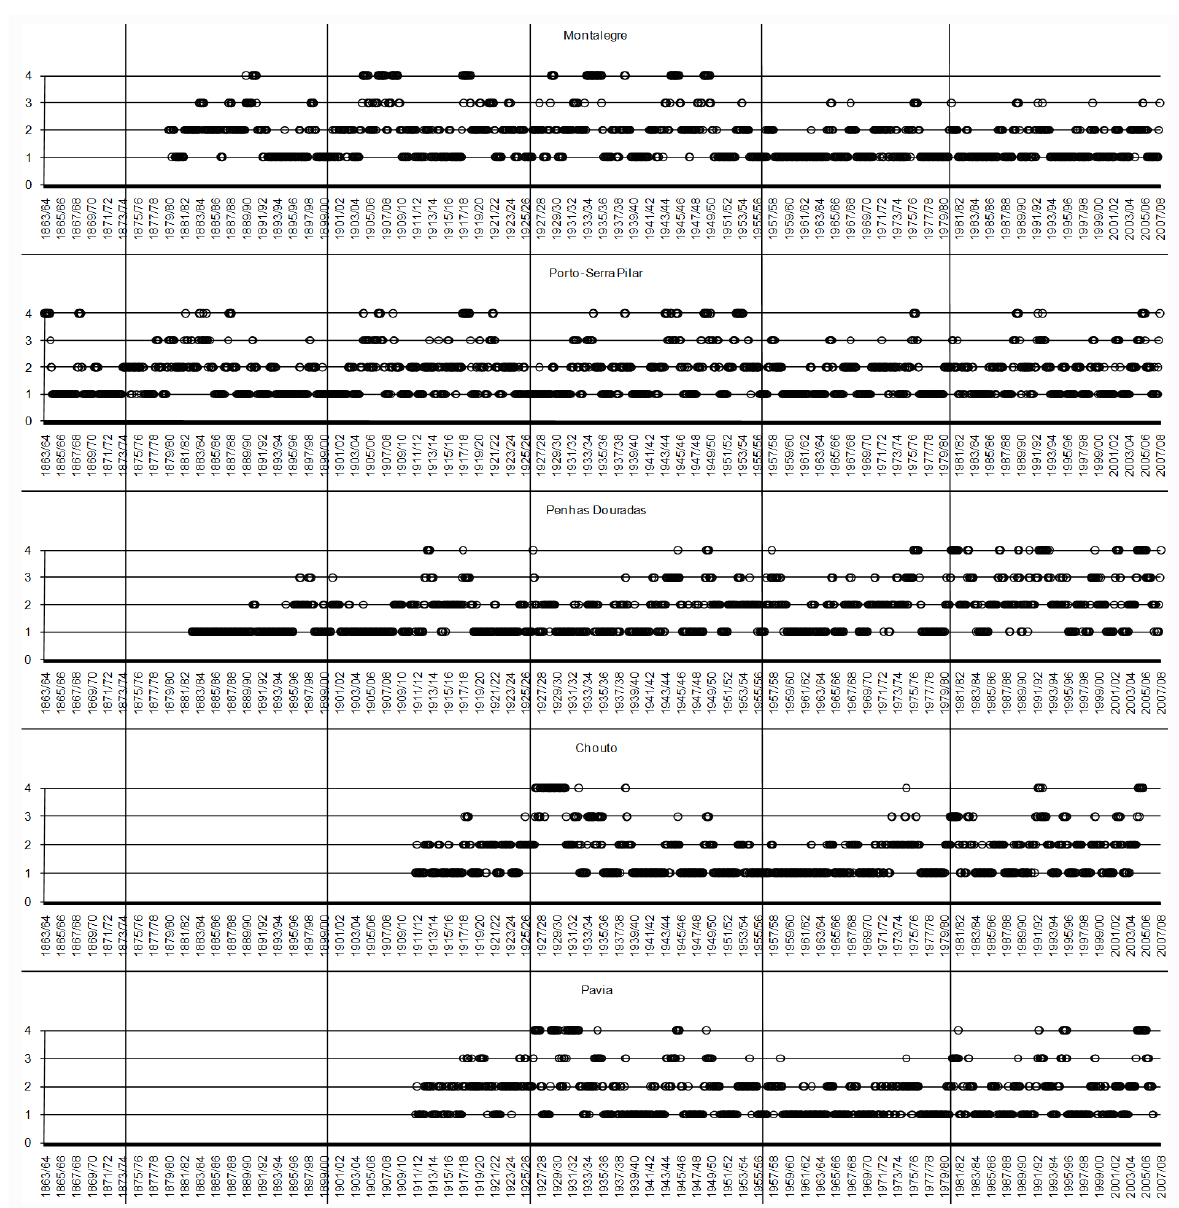
Fig. 2. Drought classes (Table 2) through time by location (sub-periods are indicated with vertical lines).